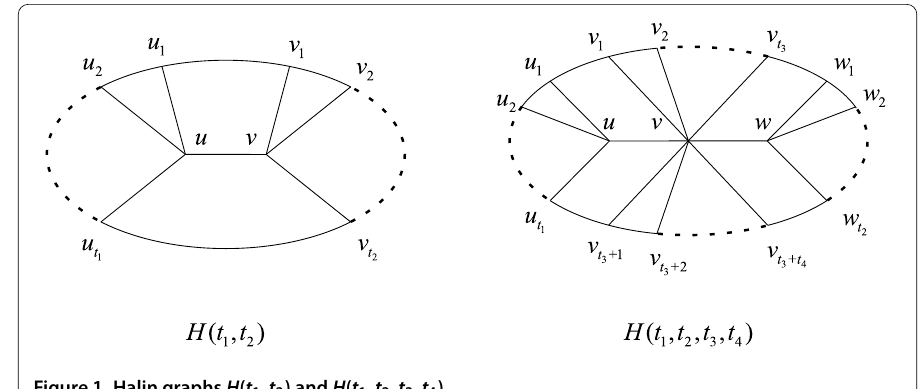
Figure 1 Halin graphs H ( t 1 , t 2 ) and H ( t 1 , t 2 , t 3 , t 4